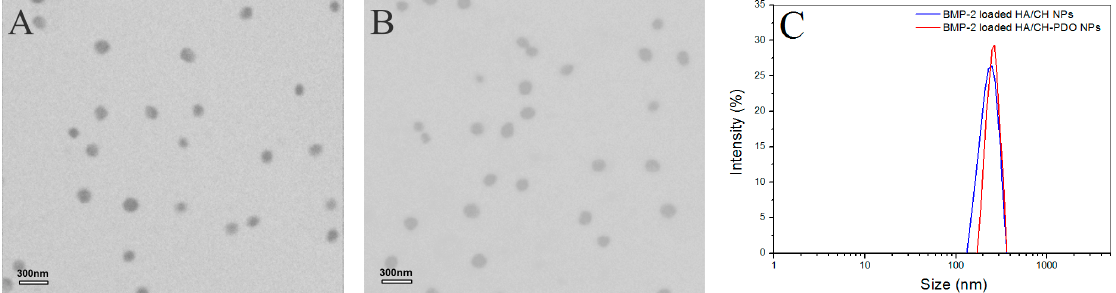
Figure 2. TEM images of BMP-2-encapsulated HA/CH NPs ( A ) and BMP-2-encapsulated HA/CH-PDO NPs ( B ) as well as their size distribution ( C ).